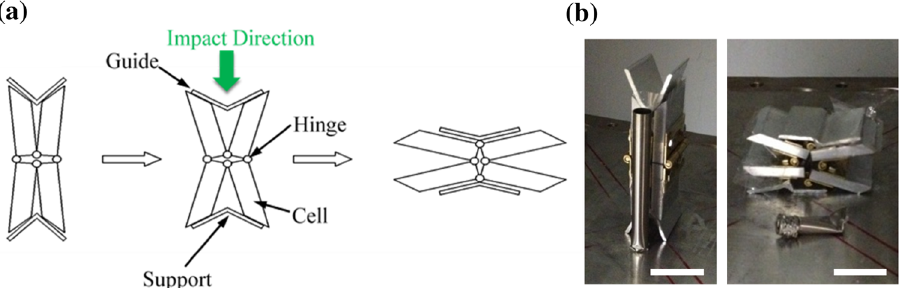
Fig. 1 a Schematic of butterfly-shaped battery module: before (left), during (middle), and after (right) deformation. b Photos of a testing sample: before (left) and after (right) impact; the scale bars indicate 20